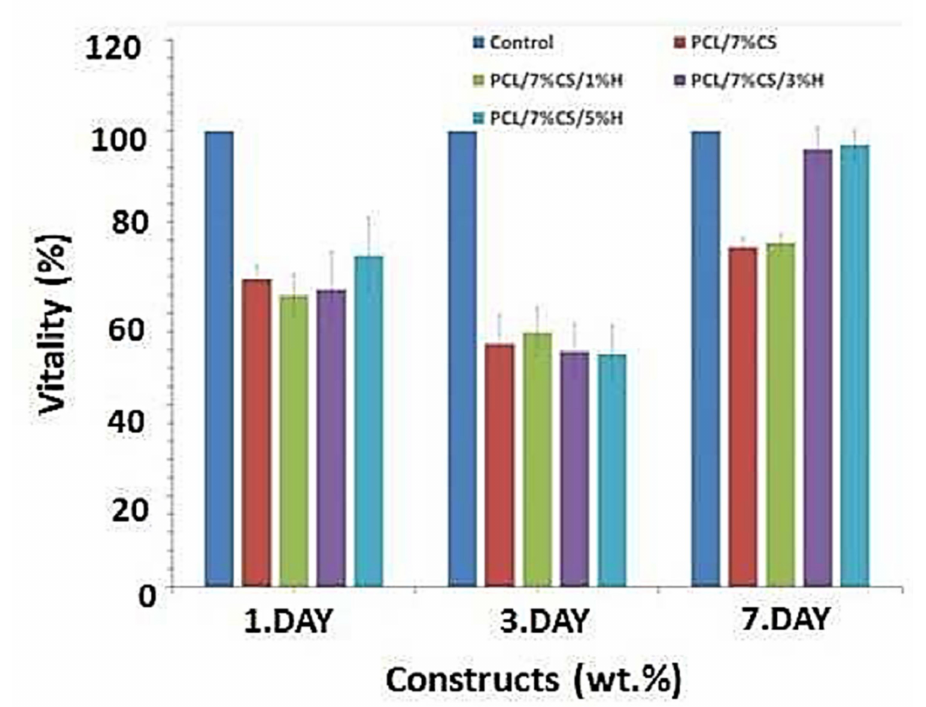
Figure 10. Results of cell vitality for all constructs showing on day 7, cell growth of PCL/7 wt.% CS/5 wt.% H was similar to the control group. Copyright 2019 John Wiley@Sons. Reprinted with permission from ref. [305].